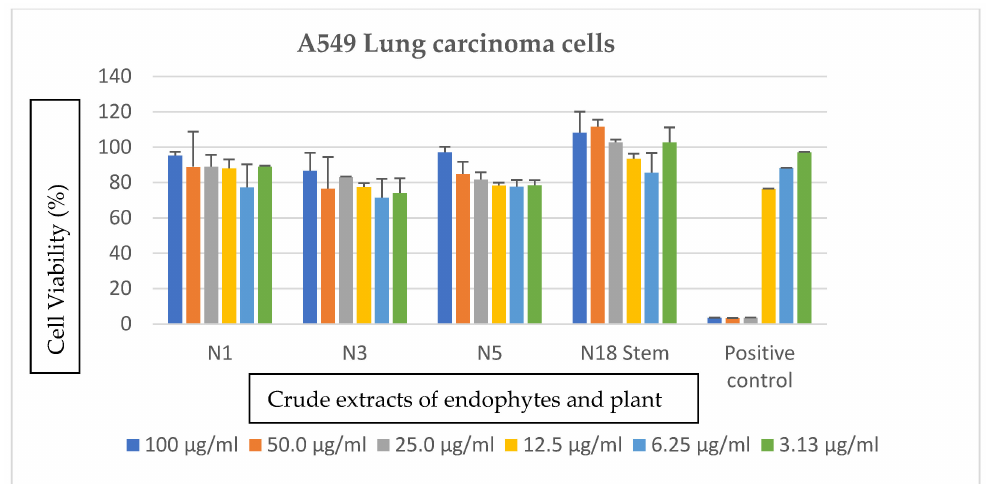
Figure 2. Cytotoxic effects of crude secondary metabolites from the stem of S. mauritianum and its bacterial endophytes on A549 Lung carcinoma cells tested at different concentrations, ranging from 100–3.13 µ g/mL. Auranofin was used as positive control. N1 = P. ananatis , N3 = P. eucalypti , N5 = P. vagans , and N18 = S. mauritianum stem.